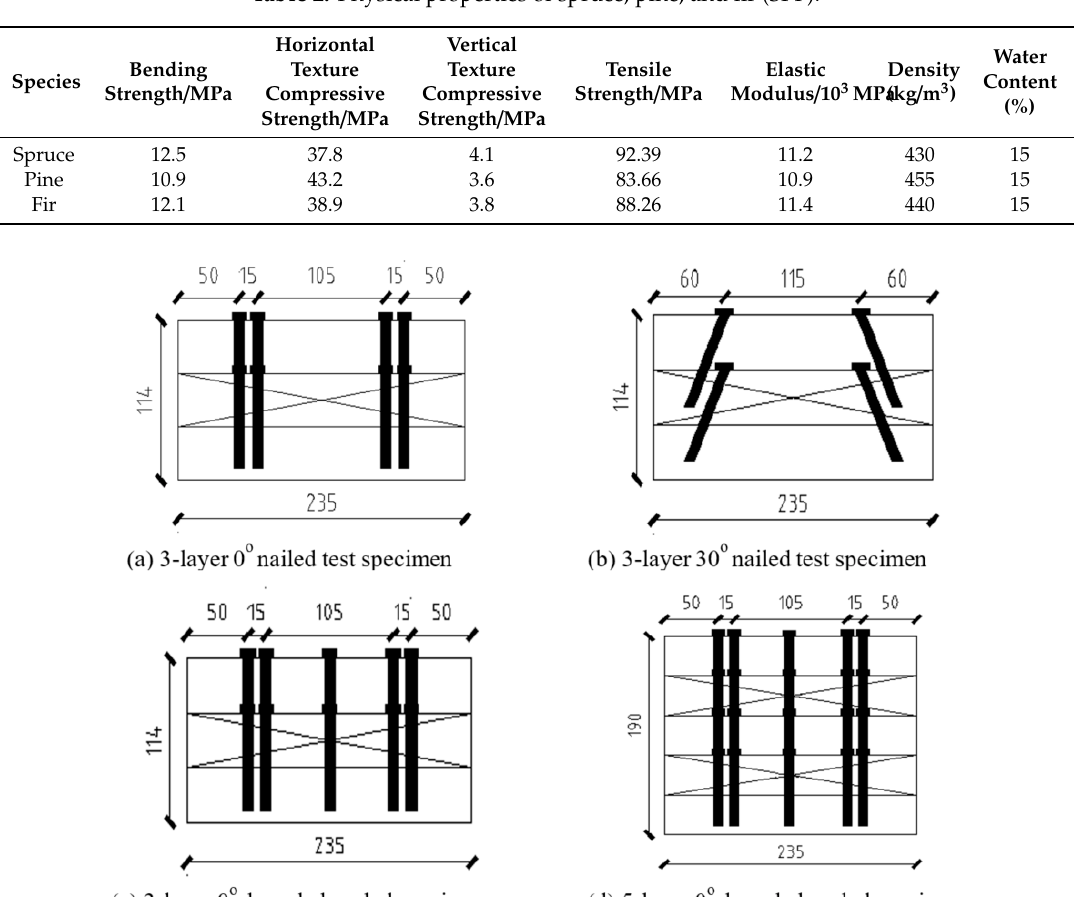
Figure 2. Partial detail of top view of each group of test specimens. 2.2. Test Setup and Experimental Procedures The bending behavior was investigated using the four ‐ point loading method. The different stress states of pure bending and bending shear zones are shown in Figure 3a ‐ c. During the test, the displacement of each section of the specimen was measured by linear variable displacement